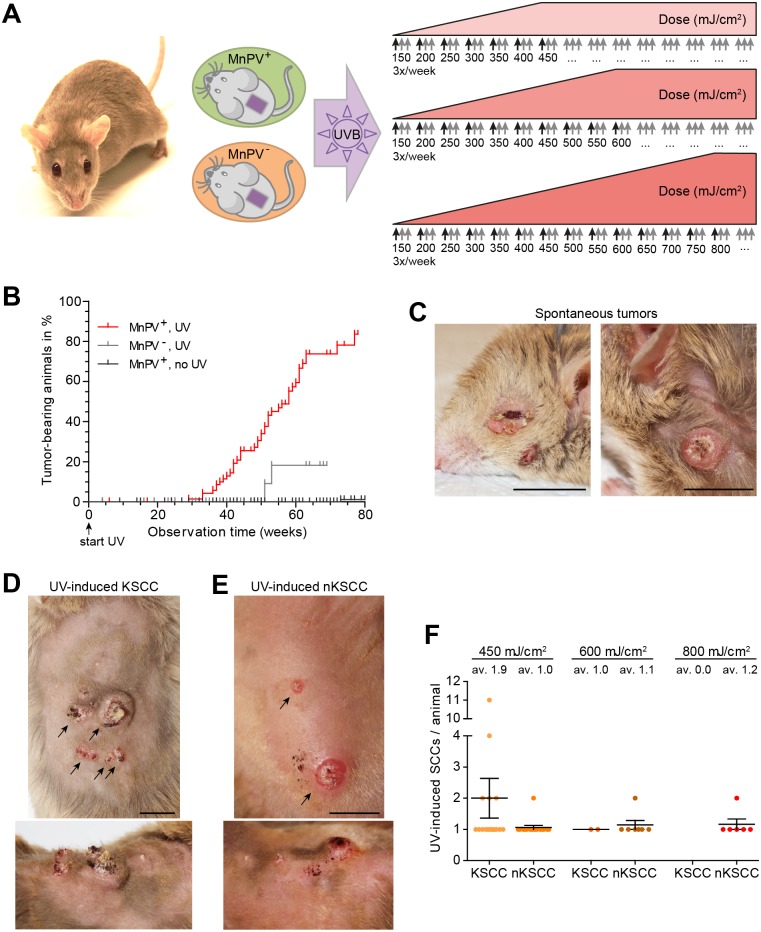
Study design and tumor development.A)
Mastomys coucha as a model for cutaneous papillomavirus infection. In the study, naturally MnPV-infected animals (MnPV+) as well as virus-free control animals (MnPV-) were irradiated three times per week with UVB. The starting dose of 150 mJ/cm2 was increased weekly by 50 mJ/cm2 until the desired final dose was reached (450, 600 or 800 mJ/cm2, respectively). Black arrows indicate an increase of the dose, gray arrows the subsequent application of this dose. The irradiation was continued until the animals were sacrificed or died. B) Kaplan-Meier curves demonstrating the percentage of irradiated virus-infected (MnPV+, UV+), virus-free (MnPV-, UV+) and unirradiated virus-infected (MnPV+, UV-) tumor-bearing animals. C) Two examples of spontaneous skin lesions arising in naturally infected animals. D) Examples of UV-induced keratinizing SCCs (KSCC) with similarities to human keratoacanthomas. E) Examples of UV-induced non-keratinizing SCCs (nKSCC) (C, D and E: scale bars: 10 mm). F) Number of KSCCs and nKSCCs in correlation with the final UV doses. Note that KSCCs preferentially appeared at the lowest dose, nKSCCs preferentially at higher doses (Mean ± SEM; animal numbers: see Table 1; av: average number of tumors).